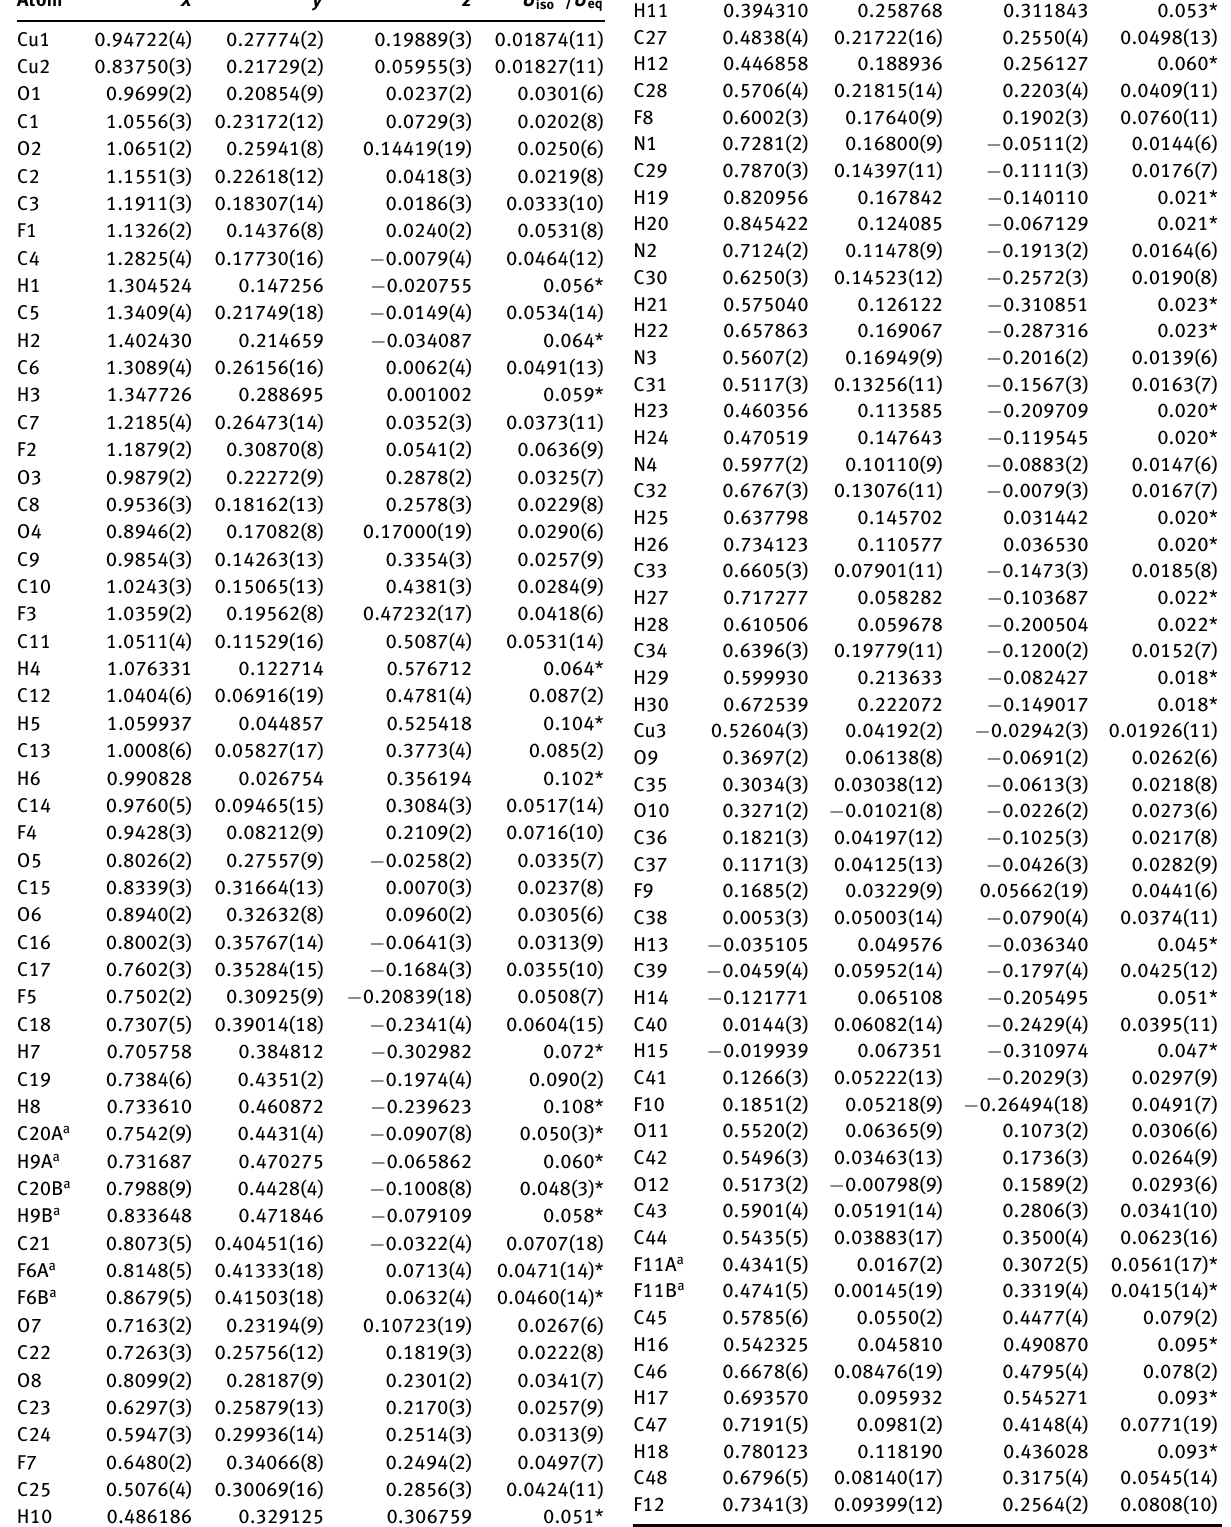
Table 2: Fractional atomic coordinates and isotropic or equivalent isotropic displacement parameters (Å 2